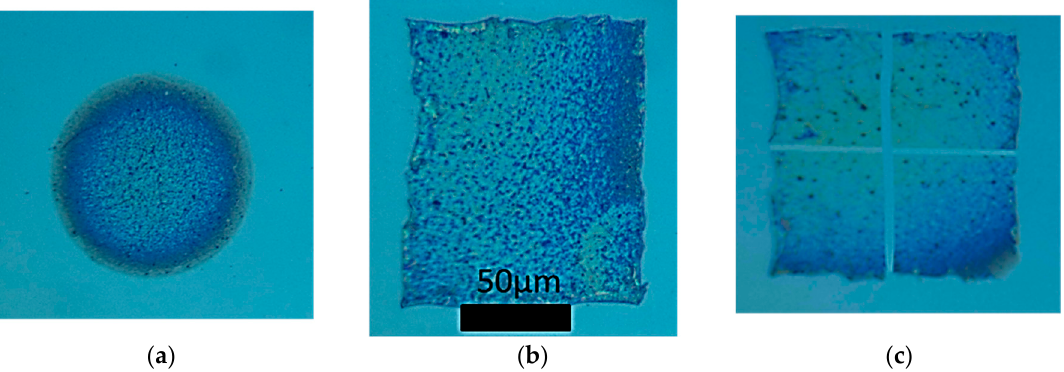
Figure 4. Optical microscope images of solid pixels transferred intact on PEN substrates, using single pulses of 20 mJ/cm 2 and wavelength of 532 nm. ( a ) circular; ( b ) rectangular; ( c ) Square. An optical filter has been used to enhance contrast.